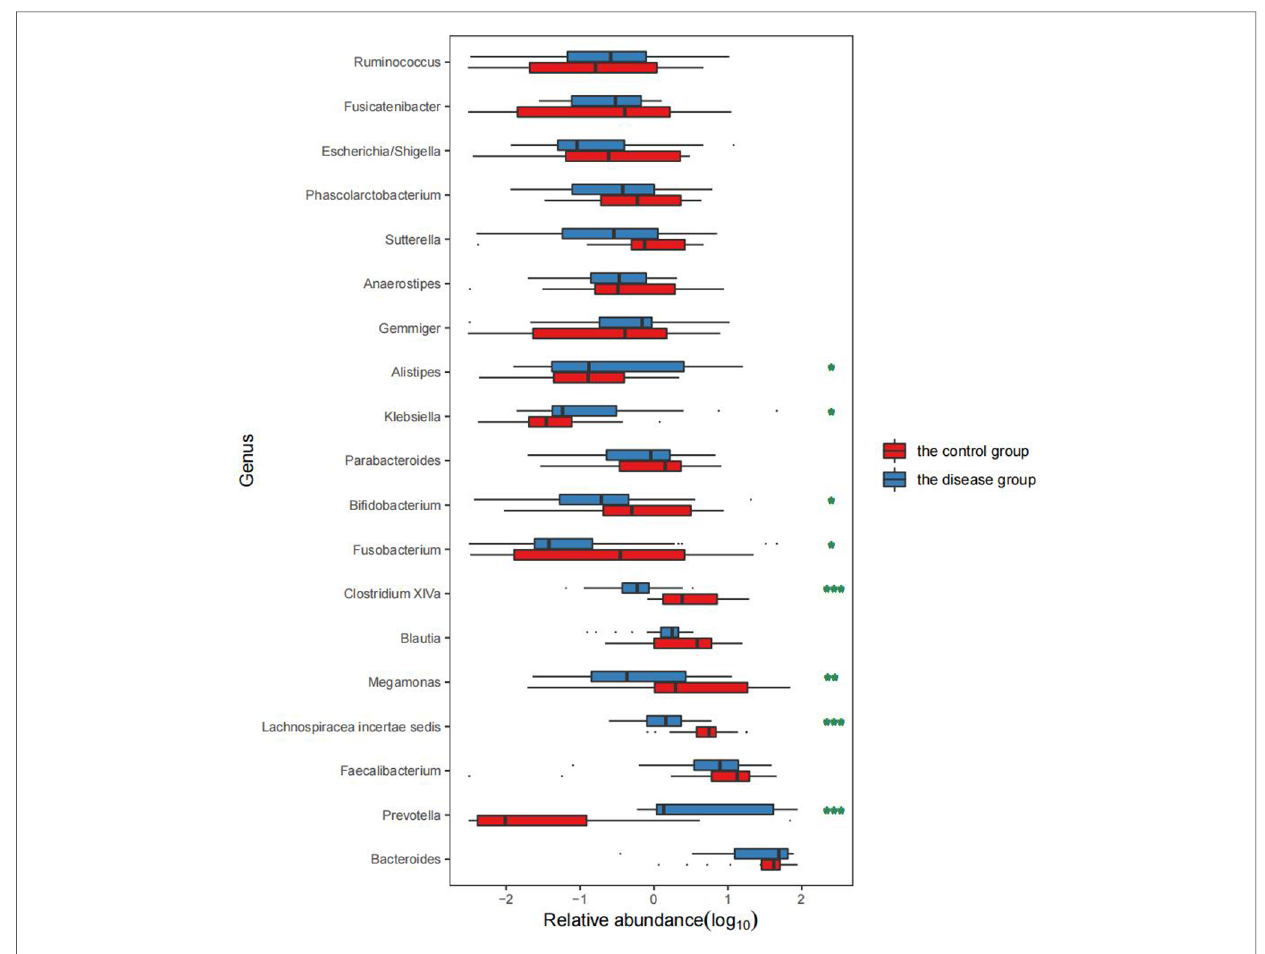
FIGURE 4 Comparison of the abundance of bacterial genera between the two groups. Remarks: * indicates P <0.05, ** indicates P <0.01, and *** indicates P <0.001 statistically signi fi cant differences between the two groups. The higher the number of asterisks, more signi fi cant the